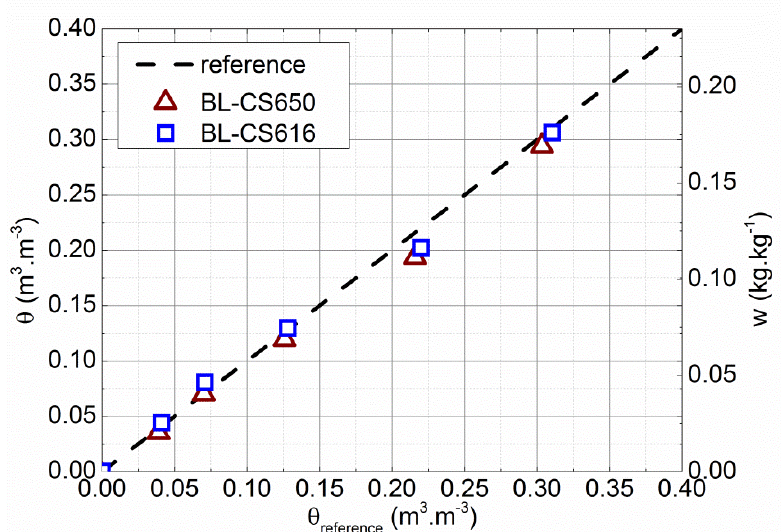
Figure 3 : Comparison between the volumetric water contents obtained by weighing ( ) and from the probes CS650 ( ) and CS616 ( ) calibrated with the bilinear